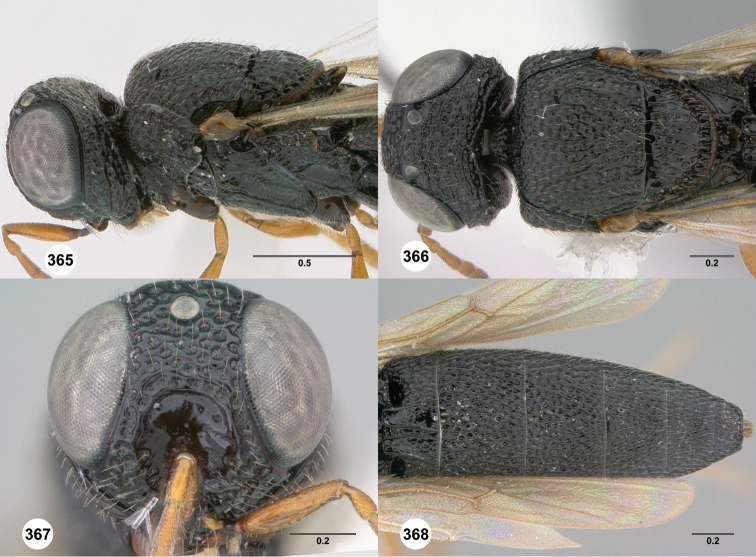
Oxyscelio truncationis sp. n., holotype female (OSUC 429933) 365 Head and mesosoma, lateral view 366 Head and mesosoma, dorsal view 367 Head, anterior view 368 Metasoma, dorsal view. Morphbank97